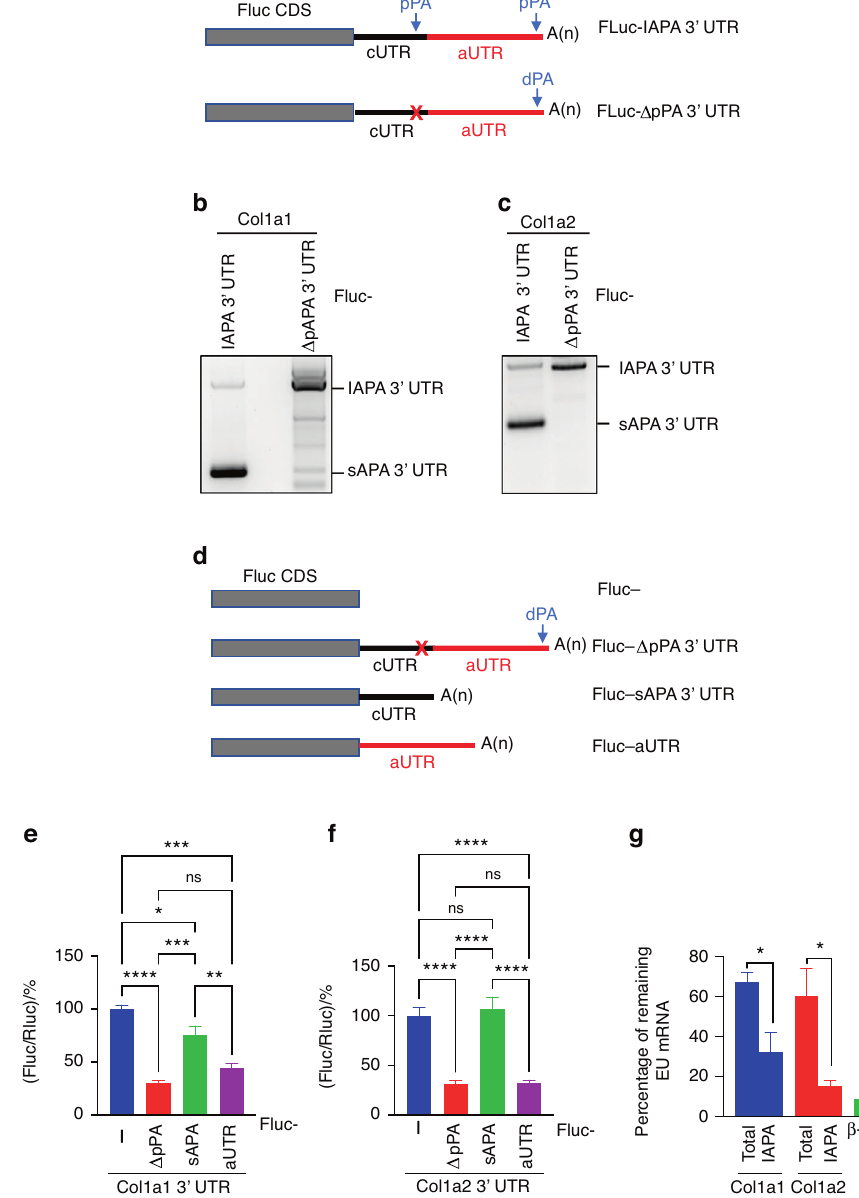
Fig. 4 Shortening of the 3 ′ UTR promotes the expression of Col1a1 and Col1a2. a Schematic of FLuc reporters that contain either the 3 ′ UTR of the lAPA isoform (i.e., full-length 3 ′ UTR) of Col1a1 or Col1a2 (FLuc-lAPA 3 ′ UTR) or the deletion mutant in which the SSR was deleted (FLuc- Δ pPA 3 ′ UTR; X denotes the position of the deleted SSR). CDS: coding region. b 3 ′ RACE-PCR of FLuc mRNA was performed on RNA that was isolated from MC-3T3 cells transfected with Col1a1 3 ′ UTR reporters shown in a . PCR was performed using an FLuc-speci fi c forward primer. The results indicate that deletion of the SSR in the FLuc- Δ pPA 3 ′ UTR reporter abrogated 3 ′ UTR shortening, resulting in the expression of FLuc mRNA as a single, long APA isoform. c As in b , except Col1a2 3 ′ UTR reporters were used. d Schematic of FLuc reporters that contain different isoforms or regions of the Col1a1 or Col1a2 3 ′ UTR. e Bar graph of the results of the dual luciferase assays that were performed on MC3T3 cells transfected with FLuc-Col1a1 3 ′ UTR reporters shown in d . FLuc activity was normalized to Renilla luciferase (RLuc) activity, and the FLuc/RLuc ratio in cells transfected with the “ empty ” FLuc (FLuc-) reporter was de fi ned as 100. f As in e except that FLuc-Col1a2 3 ′ UTR reporters were used. n = 4 – 5 independent transfections, each measured in triplicate. g Bar graph of the results of the pulse-chase experiments used to measure RNA decay. MC3T3 cells were incubated with 5-ethynyl uridine (EU), which is an analog of uridine, for 2 h to label the nascent RNA during the “ pulse step ” . Cells were then either collected to determine the total level of EU-labeled mRNA (EU mRNA) or grown for 24 h in EU- free medium during the “ chase step ” . At each timepoint, EU RNA was puri fi ed (see Materials and methods), and the level of each of the speci fi ed EU mRNA was determined using RT ‒ qPCR. Primers that bind to the aUTR were used to speci fi cally quantify the expression of the lAPA isoform of Col1a1 or Col1a2 (Table S14). The level of EU mRNA measured after the pulse step was de fi ned as 100%, and the graph shows the % remaining after the 24-h chase step. The results demonstrate faster loss of the Col1a1 and Col1a2 lAPA isoforms compared to the total mRNA. β -actin mRNA was used as a positive control for EU mRNA decay, and consistent with its reported half-life ( ∼ 6.6 h), 50 <10% remained after the 24-h chase. The gel images are representative of three independent replicates. The bar graphs present the average ± SEM. (ns) P > 0.05; * P < 0.05; ** P < 0.01; *** P < 0.001; **** P < 0.000 1 using one-way analysis of variance (ANOVA) followed by Tukey ’ s post hoc test for e and f , and unpaired Student ’ s t test for